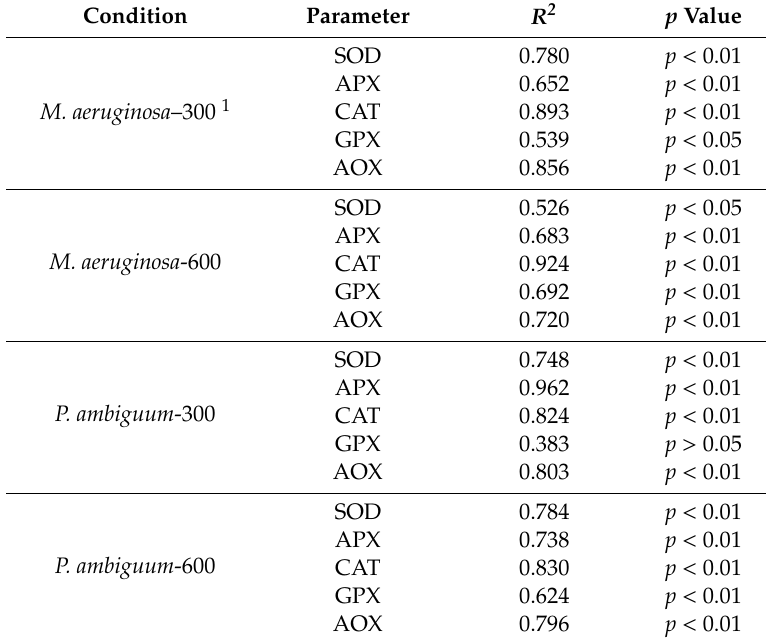
Table 1. Pearson’s correlation test results of the correlation between H 2 O 2 and antioxidant levels, (SOD), and total antioxidants